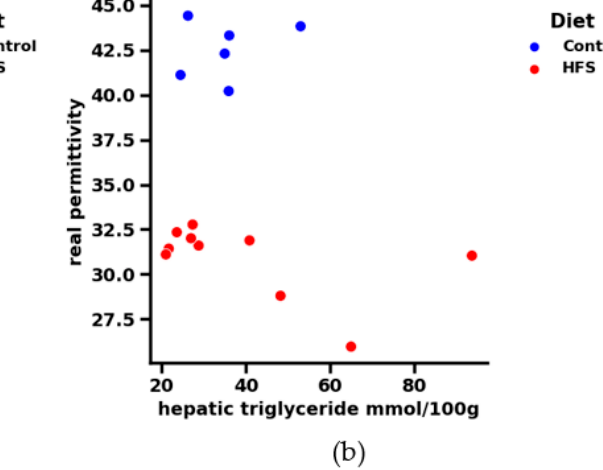
Figure 7. ( a ) Correlation between real permittivity and liver tissue glucose at 1 GHz. The regime is dissociated by color: blue for the control and orange for the HFS diet. ( b ) Correlation between real permittivity and hepatic triglyceride of liver tissue at 1 GHz. The regime is dissociated by color: blue for the control and orange for the HFS diet.